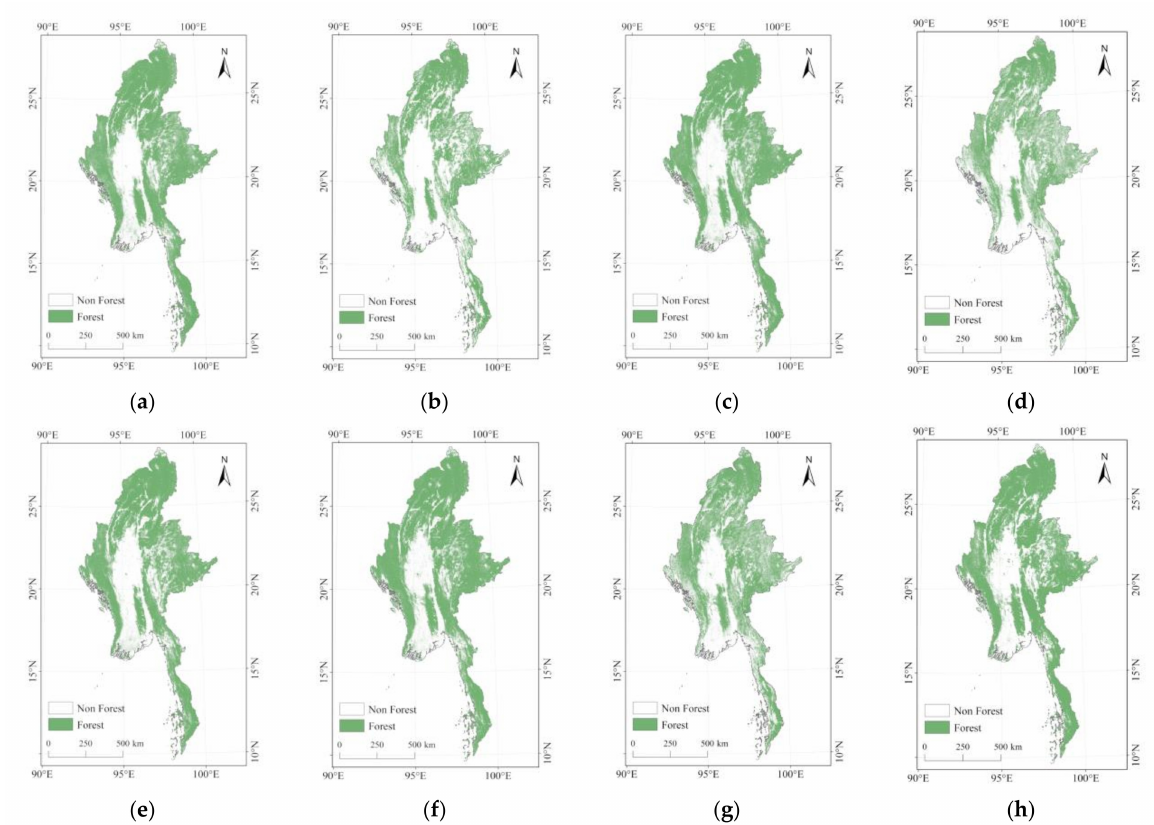
Figure 3. Spatial distribution of forests in Myanmar extracted from eight global land cover datasets. ( a ) Hansen2010; ( b ) CCI-LC-2015; ( c ) FROM-GLC-2015; ( d ) GLC-FCS-2015; ( e ) FROM-GLC-2017; ( f ) FROM-GLC10; ( g ) GLC-FCS-2020; ( h )